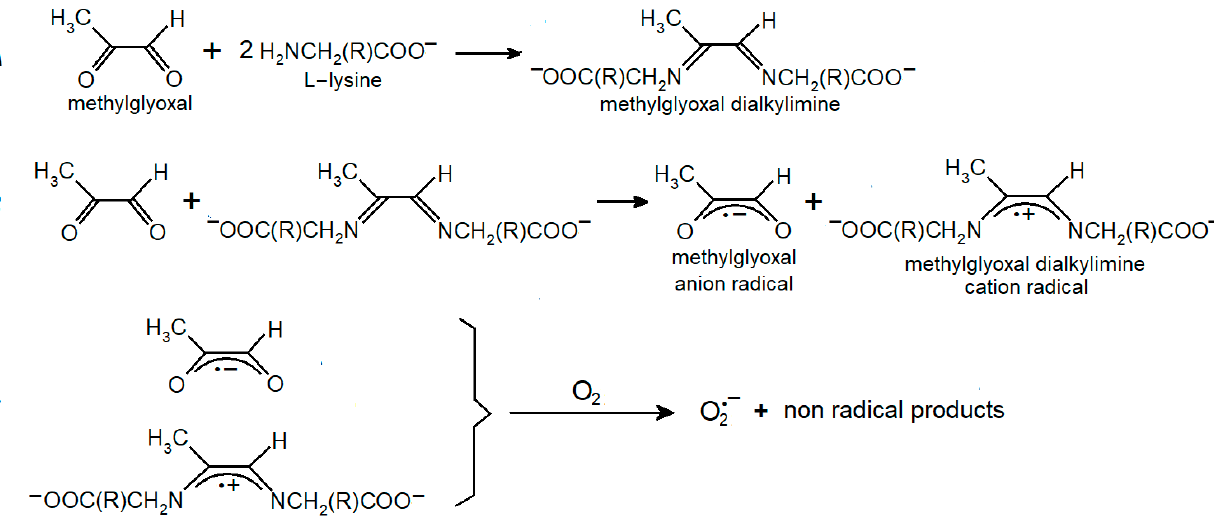
Figure 2. The scheme of free radical intermediate formation during MG’s interaction with lysine. ( A ) The formation of the MG Schiff base with lysine (MG dialkilimine). ( B ) The one-electron oxidation of dialkylimine by MG that forms MG anion radicals (semidion) and Schiff base cation radicals. ( C ) The production of superoxide anion radicals (O 2• − ) as a result of the one–electron oxidation of MG and dialkylamine free radicals by O 2 .